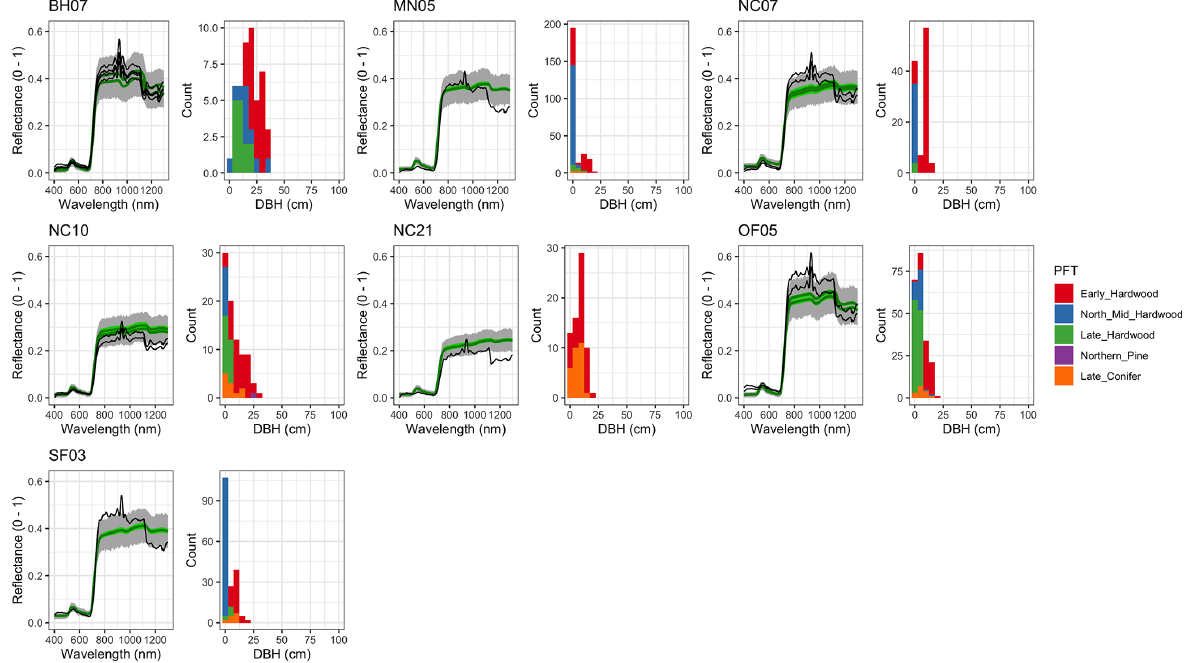
Figure A11. As above but for sites where early hardwood trees had the largest mean DBH.